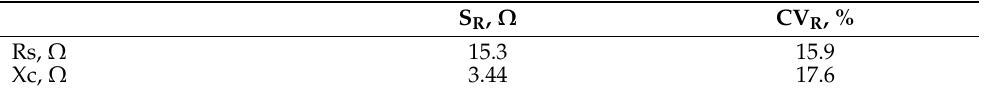
Table 2. Repeatability (S R ) and coefficient of variation of repeatability (CV R ) of resistance (Rs) and reactance (Xc).